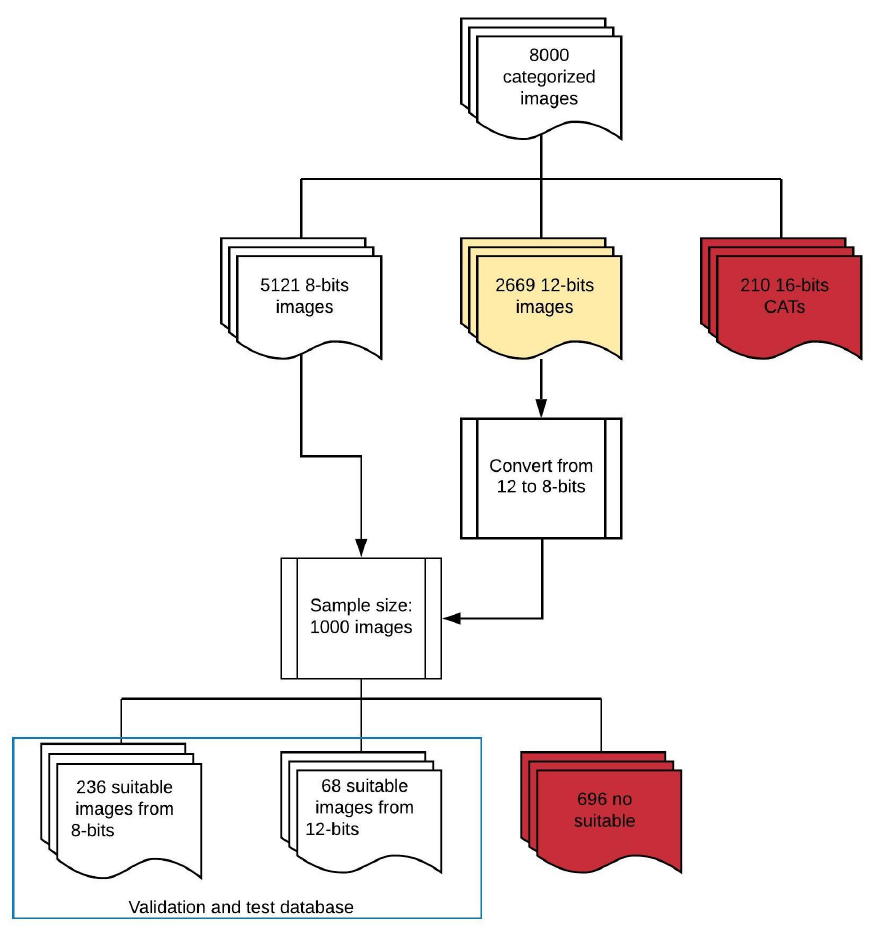
Figure 1. Flowchart followed with the categorized images.